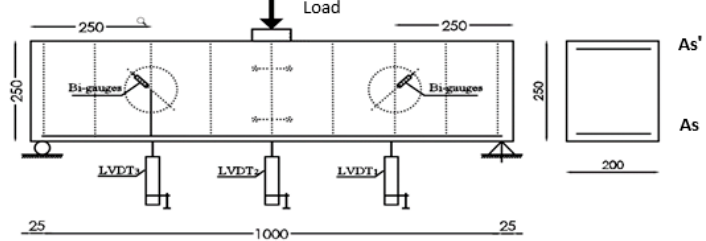
Figure 12. Details of the tested beams and instrumentations.